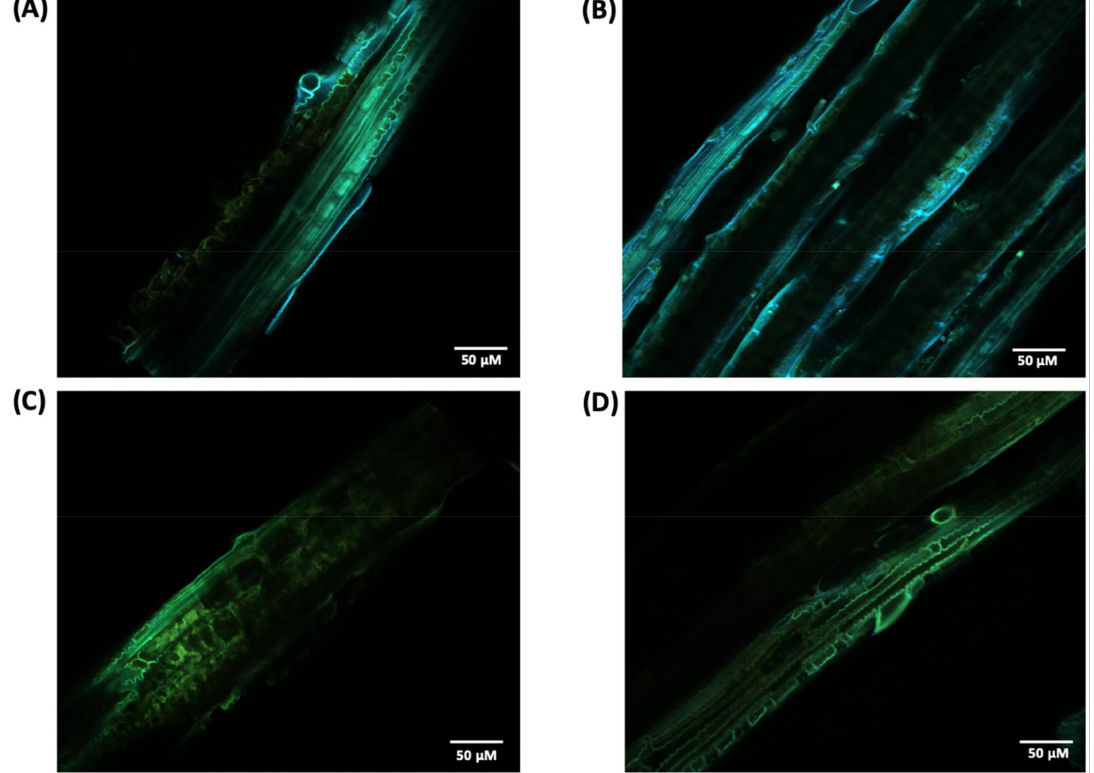
Figure 9. CLSM image of non-treated ( A , B ) and crude laccase pretreated ( C , D ) P. maximum